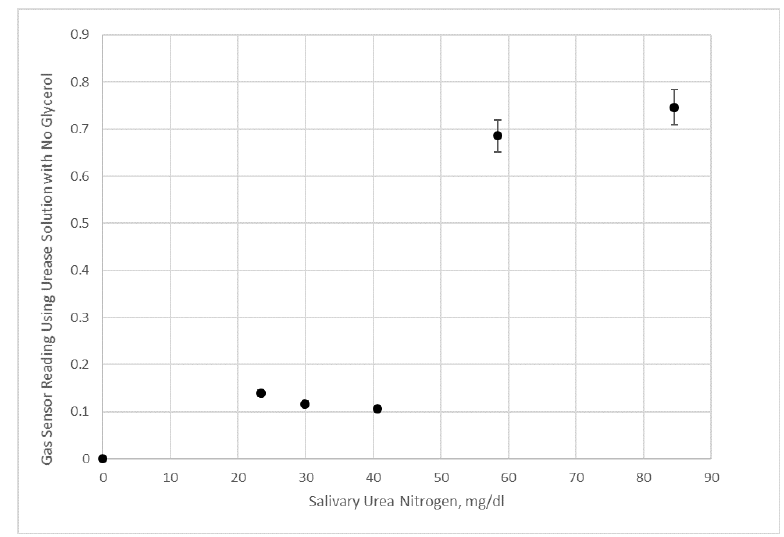
Figure 12. Electronic nose measurement of saliva samples and saliva samples with added urea given in terms of salivary urea nitrogen. Data shown are using a urease solution with no added glycerol.